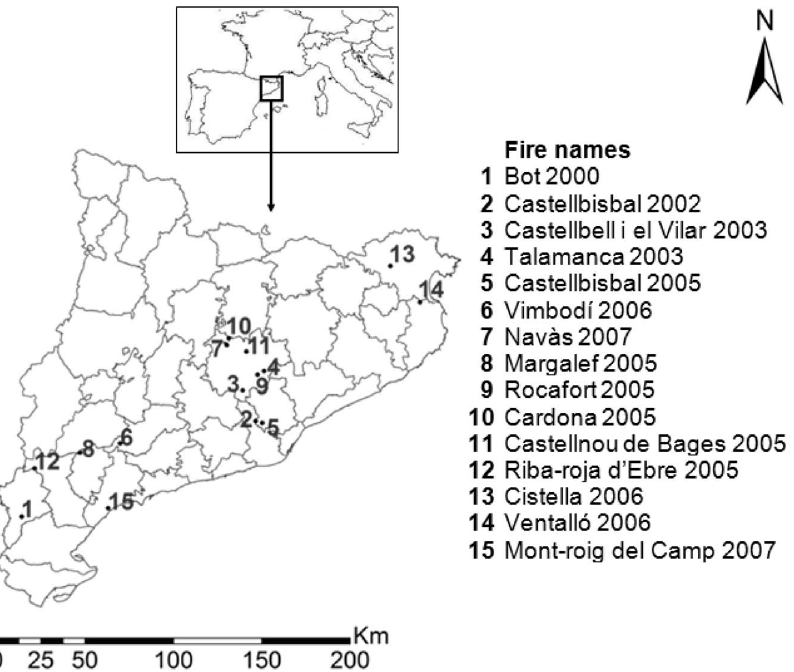
Figure 1. Names and location of the fires studied. Black points indicate the center of the fire and inner lines indicate regions.